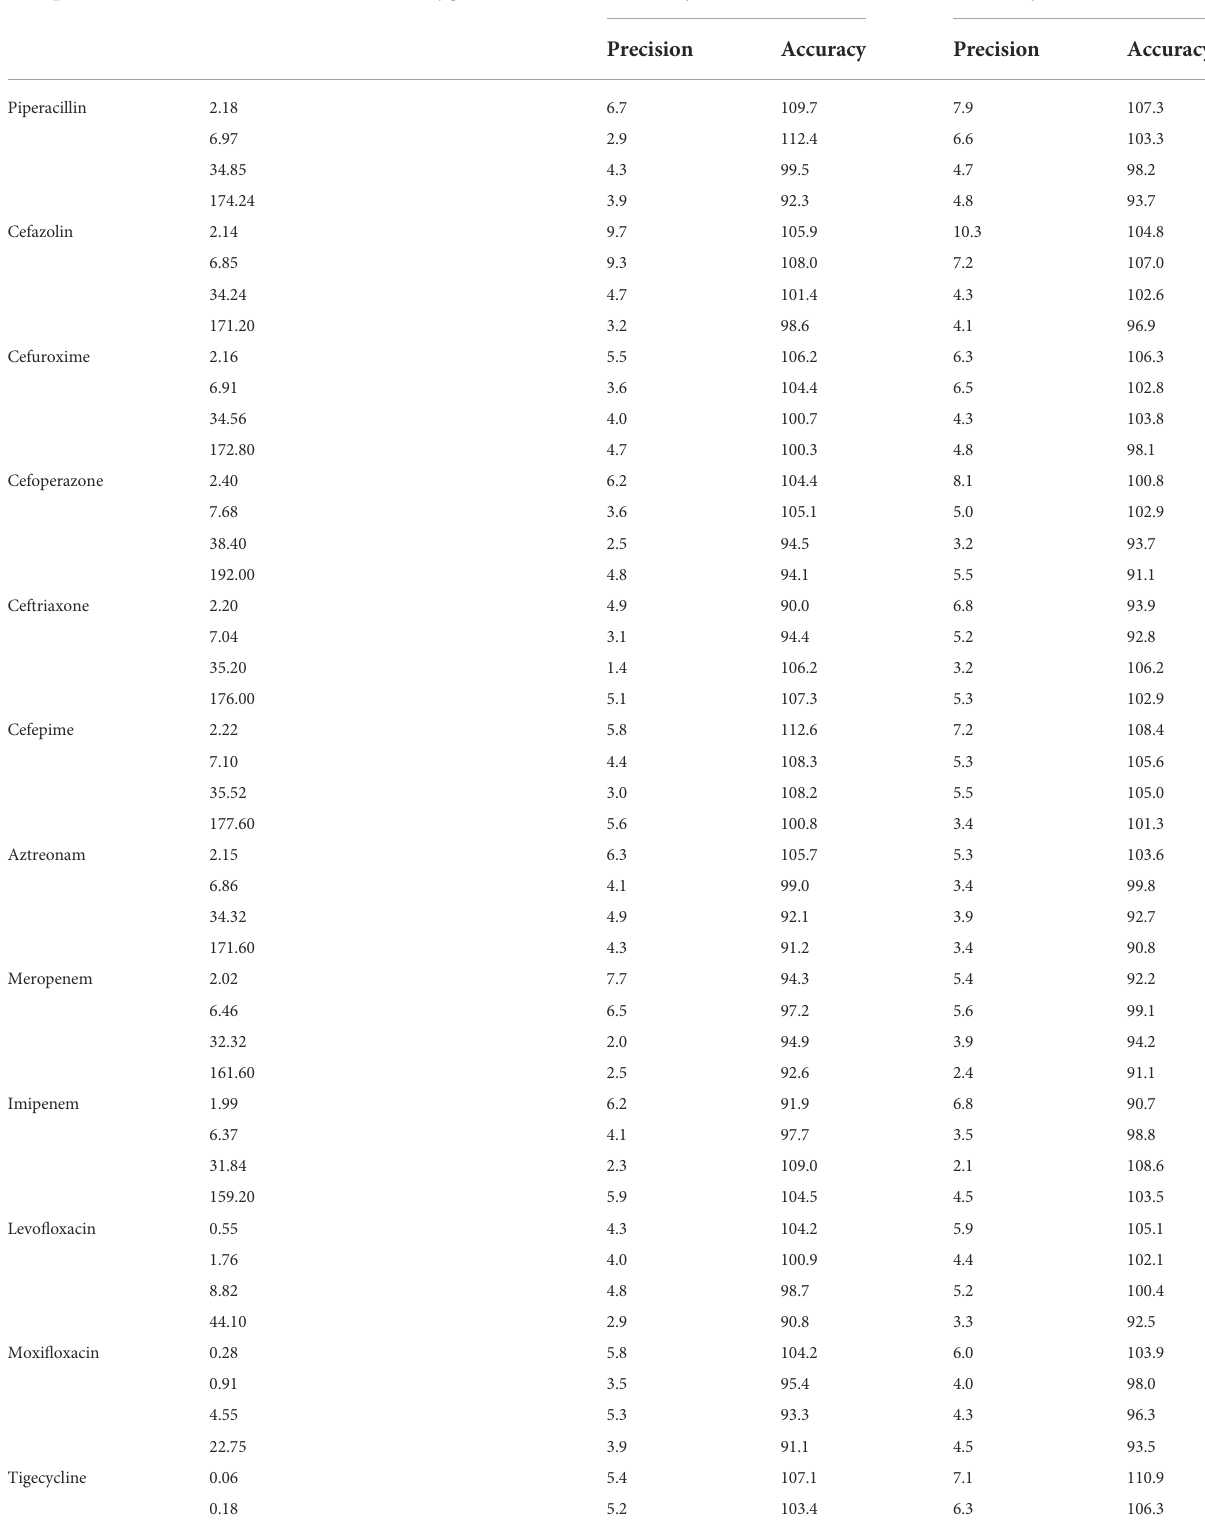
TABLE 4 Intra- and inter-day accuracy and precision of 18 antimicrobial agents in human plasma.